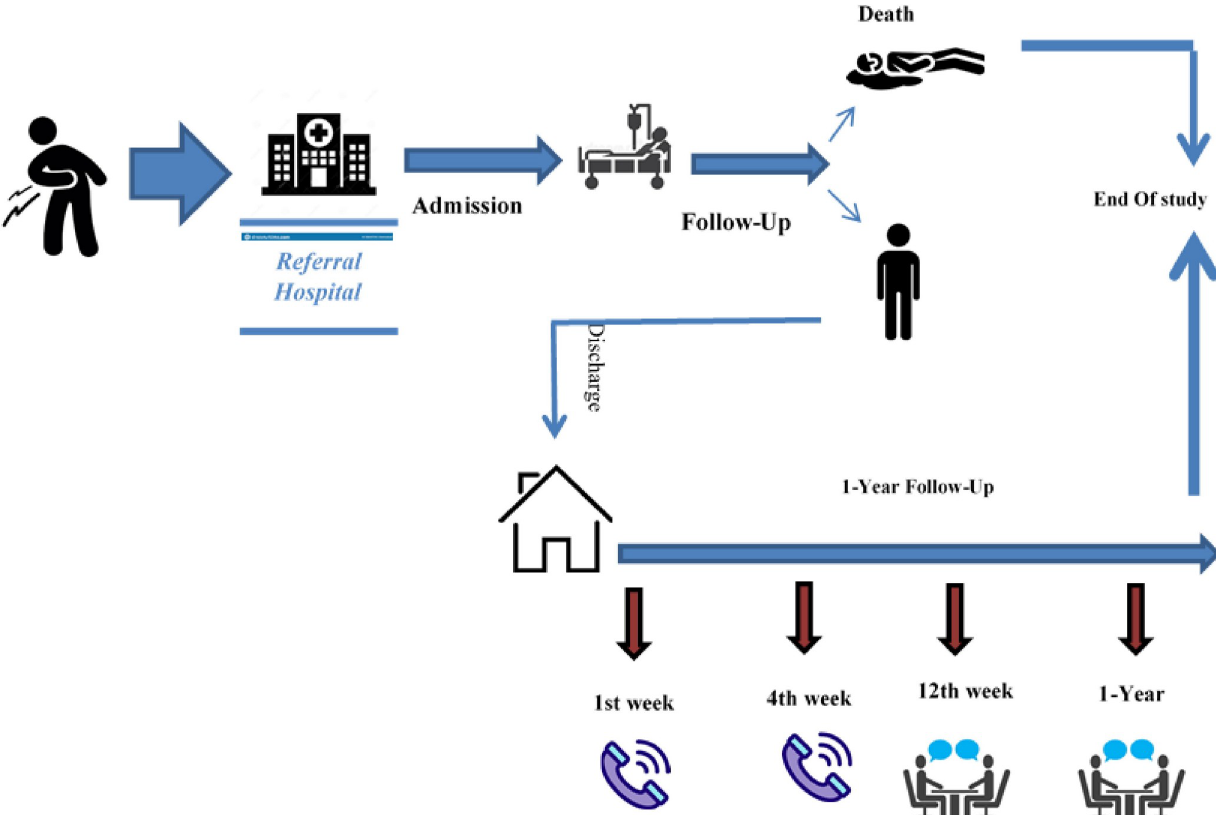
Fig 1. The scheme of the Khorshid COVID Cohort (KCC)